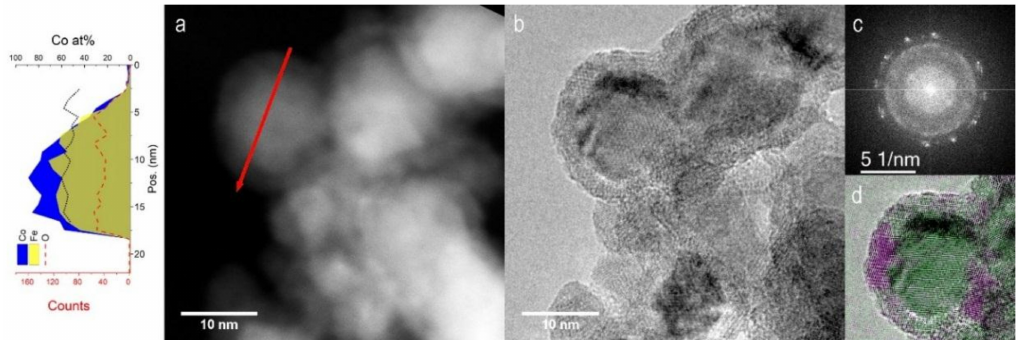
Figure 6. TEM analysis of Fe 52 Co 48 NPs. ( a ) HAADF-STEM image and the corresponding EDX profile taken along the red arrow. The blue and yellow areas and the red dashed line represent Co, Fe and O X-ray fluorescence counts. The black solid line is the Co/(Co+Fe) atomic ratio within the NP; ( b ) HR-TEM image of the same area together with its ( c ) Fast-Fourier-Transform (FFT); ( d ) Mapping of crystal phases obtained from the analysis of planar spacing. α -FeCo (110) and cobalt ferrite (311) planes are represented in green and purple, respectively.